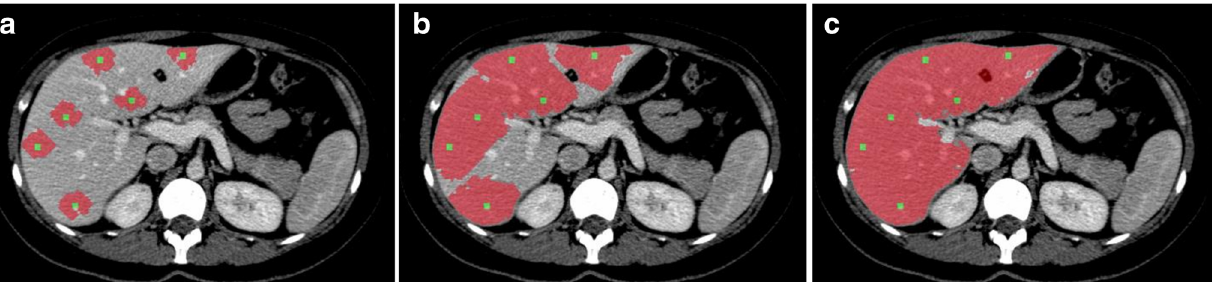
Fig. 11 Seeded region-growing technique. a Seeds are positioned inside the regions of interest by user. b Pixels are iteratively aggregated if their intensity is similar to those already tagged. c The liver parenchyma is segmented